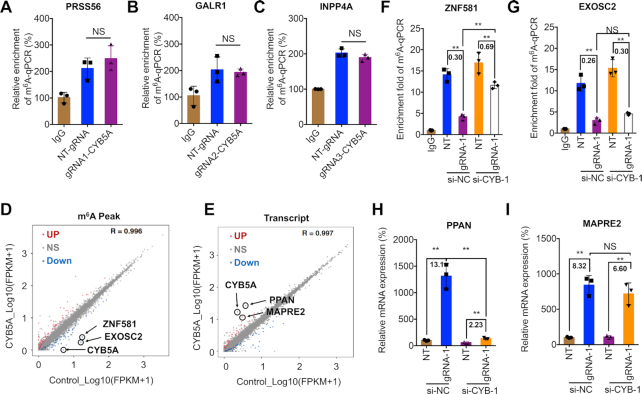
Specificity and non-additive effects of dm6ACRISPR on m6A demethylation. (A–C) Cells were transfected with dCas13b-ALKBH5 and NT-gRNA or gRNA1/2/3 of CYB5A, respectively, for 24 h, with m6A levels of PRSS56 (A), GALR1 (B), or INPP4A (C) measured by m6A -RIP-qPCR analysis; (D) Smooth scatter plot displaying mean methylation in NT-gRNA (control) or CYB5A gRNA-1-transfected HEK293T cells for 24 h with dCas13b-ALKBH5 (total 25 888 peaks). Red dots indicate peaks with significant upregulation while blue dots indicate peaks with significant downregulation in methylation (P < 0.05); (E) Smooth scatter plot displaying mean expression of transcripts in NT-gRNA (control) or CYB5A gRNA-1-transfected HEK293T cells for 24 h with dCas13b-ALKBH5 (total 25,603 transcripts). Red dots indicate transcripts with significant upregulation while blue dots indicate transcripts with significant downregulation (P < 0.05); (F, G) HEK293T cells were transfected with si-NC or si-CYB5A-1 together with NT-gRNA (NT) or CYB5A gRNA-1 combined with dCas13b-ALKBH5 for 24 h. The m6A fold enrichment of ZNF581 (F) or EXOSC2 (G) was analyzed by m6A RIP-qPCR analysis, with fold changes listed; (H, I) cells were transfected with si-NC or si-CYB5A-1 together with NT-gRNA (NT) or CYB5A gRNA-1 for 24 h. Relative mRNA levels of PPAN (H) or MAPRE2 (I) were analyzed by qPCR analysis, with fold changes listed. Data are presented as mean ± SD from three independent experiments. ** P < 0.01, NS, no significant, by one-way ANOVA with Bonferroni test.